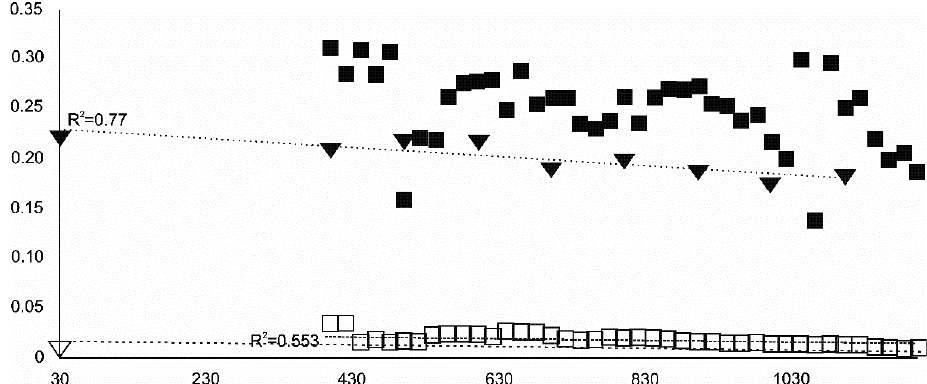
Figure 13. Relation of temperature (bottom axis, in °C) to positions of major reflections (in Å) for wüstite. LSCB sample—filled symbols. USCB sample—empty symbols. Squares—main reflection. Triangles—main reflection second-wüstite-phase.